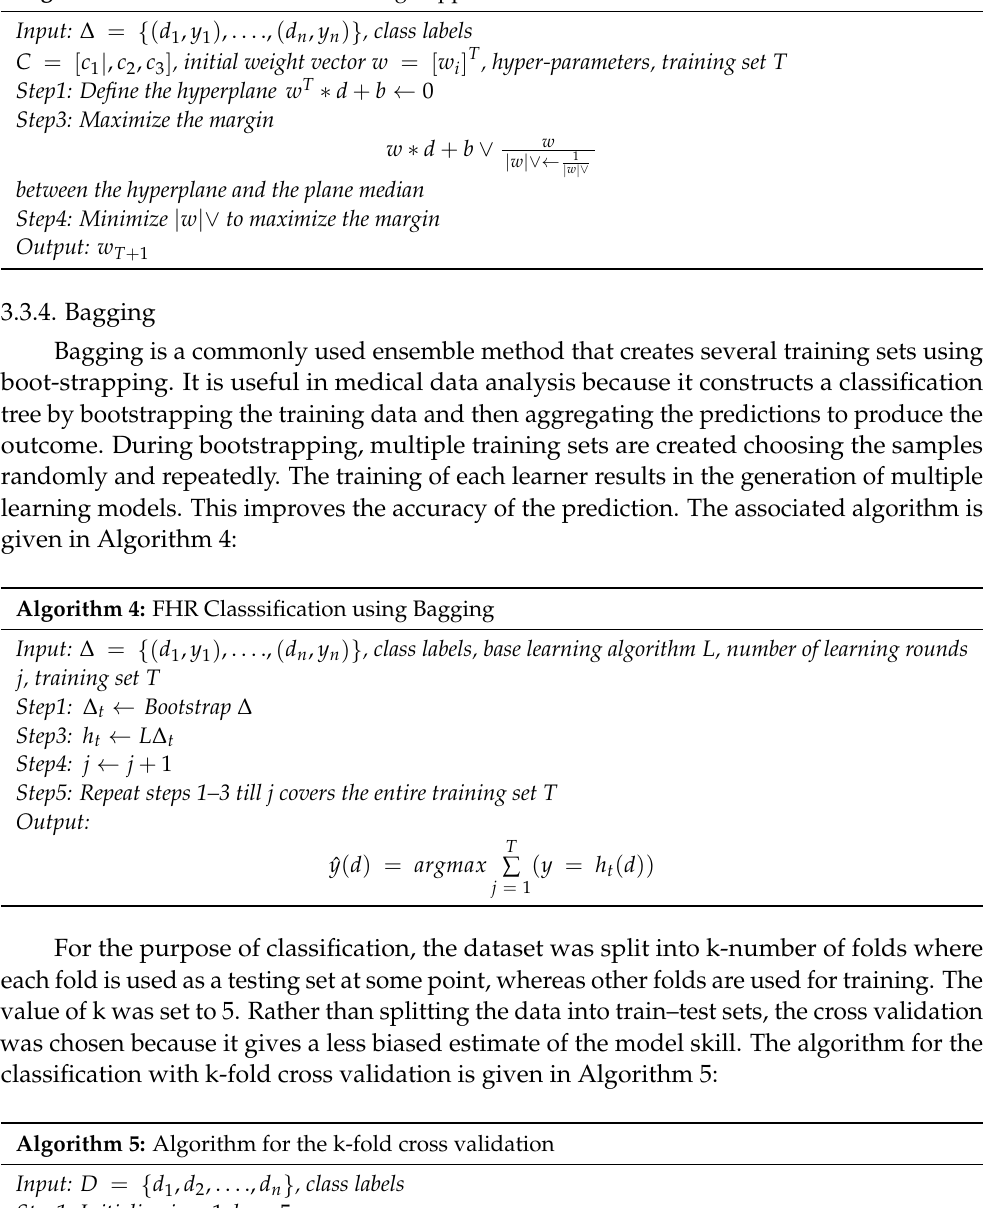
Algorithm 3: FHR Classsification using Support Vector Machine